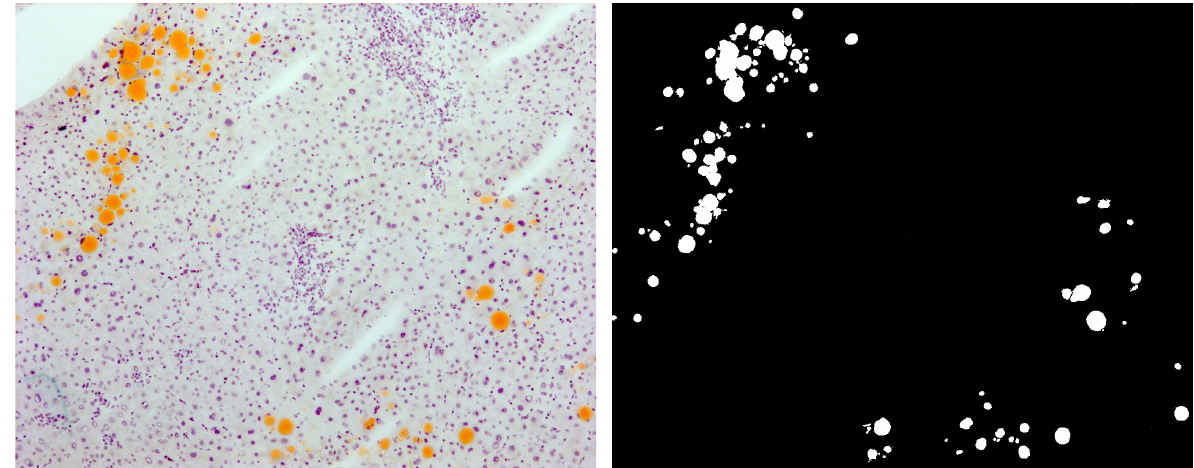
Figure 5. Original image ( left ) and manually classified image ( right ).